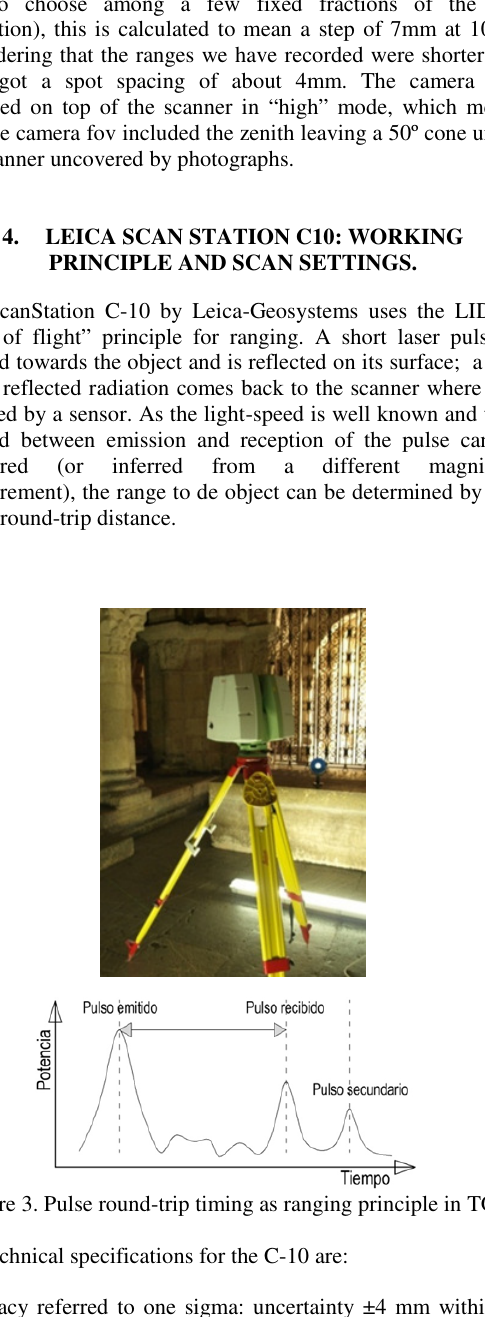
Accuracy referred to one sigma: uncertainty ±4 mm within 1- 50m